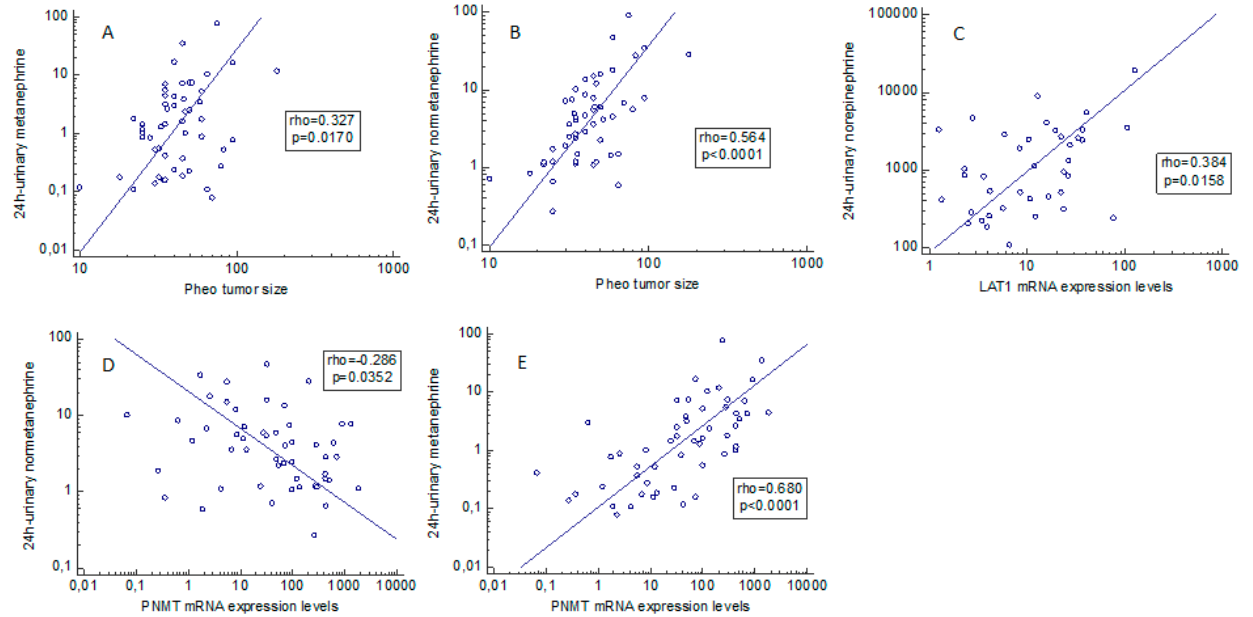
Figure 2. ( A – E ) Correlation between pheochromocytoma secretory behavior and clinical/molecular aspects. Statistically significant associations between L-type amino acid transporter 1 and phe- nylethanolamine N-methyltransferase expression levels and biochemical and clinical data, based on